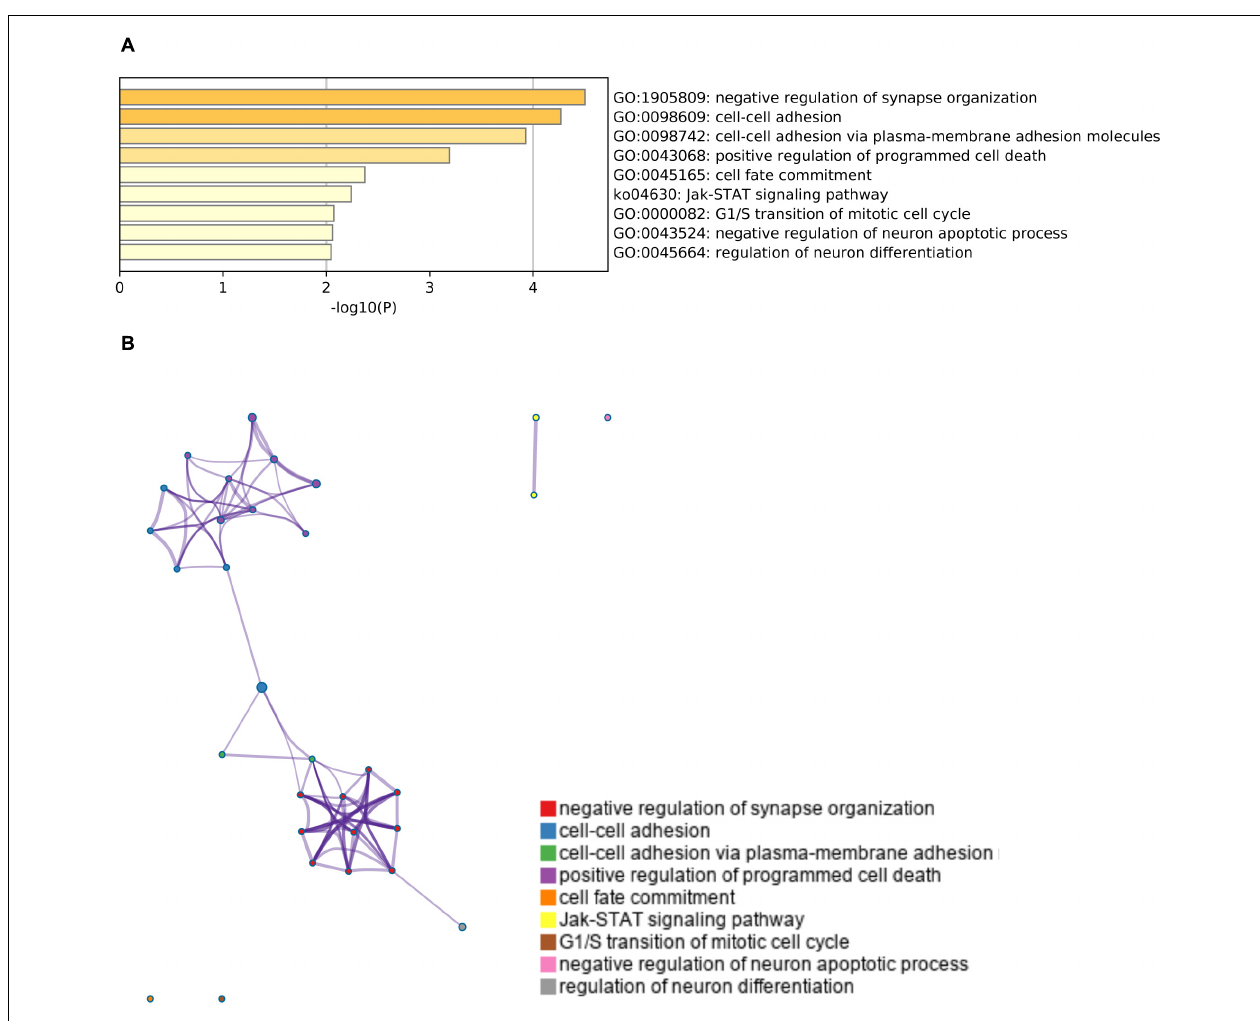
FIGURE 4 | Gene set enrichment analysis of downregulated genes. (A) A heatmap of enriched terms across the input genes list. Darker colors indicate smaller p values. Downregulated genes were related to the pathways that mediate negative regulation of synapse organization (GO: 1905809) and cell-cell adhesion (GO: 0098609 and GO: 0098742). Please see Supplementary Table 4 for the list of enriched terms of downregulated genes. (B) Metascape enrichment analysis. Clustering was made based on similarity (similarity >